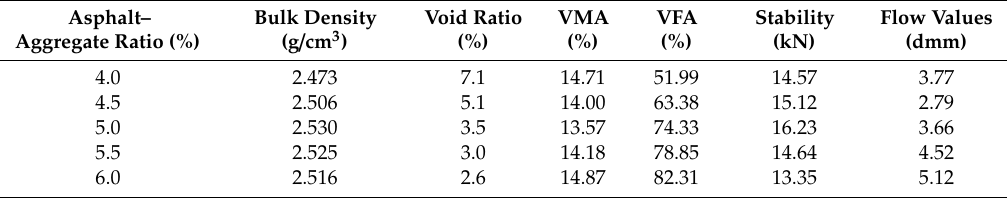
Figure 2. Gradation curves of the designed asphalt concrete. Table 2. Test results of the Marshal samples with different asphalt–aggregate ratios.